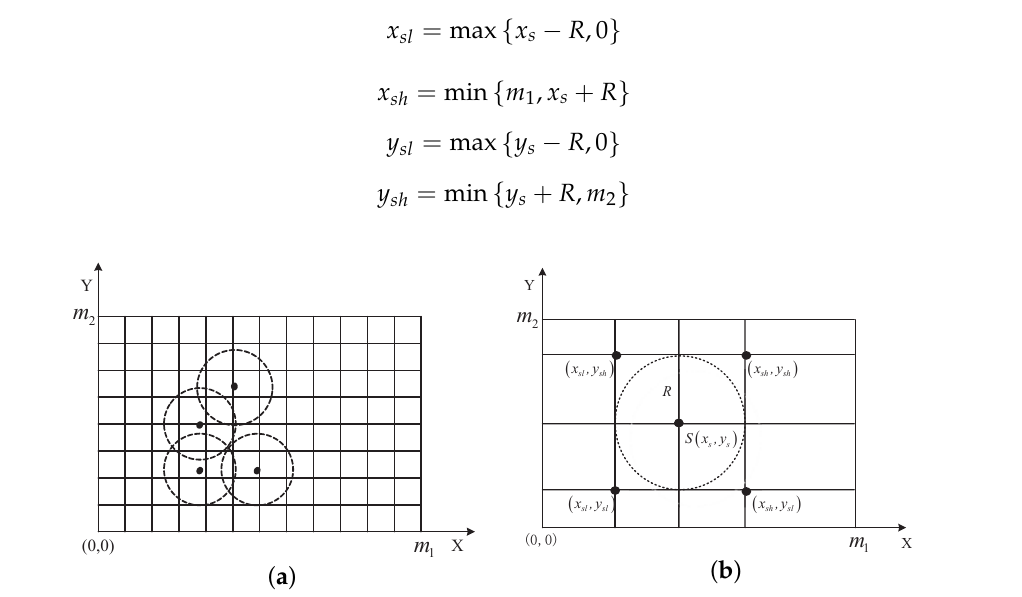
Figure 3. Coverage situations varication of monitoring area. ( a ) Monitoring area gridding; ( b ) Sensing range of sensor